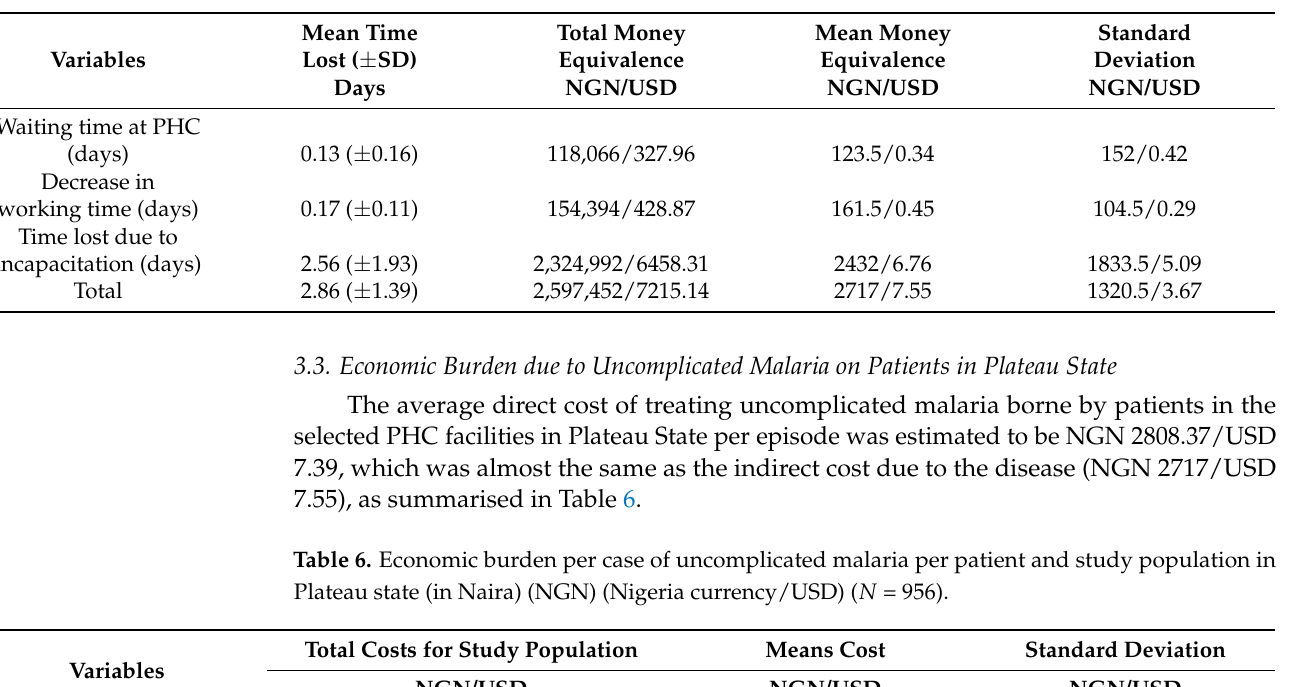
Table 5. Average time lost (days) and money equivalence by patients due to uncomplicated malaria in Plateau State (in Naira) (NGN) (Nigeria currency/USD) ( N = 956).